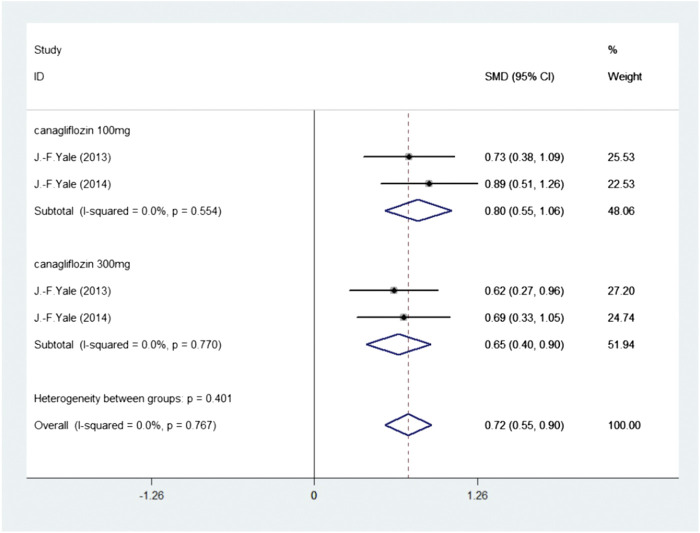
Meta-analysis and forest plot of Hematocrit for experimental group compared with control group.